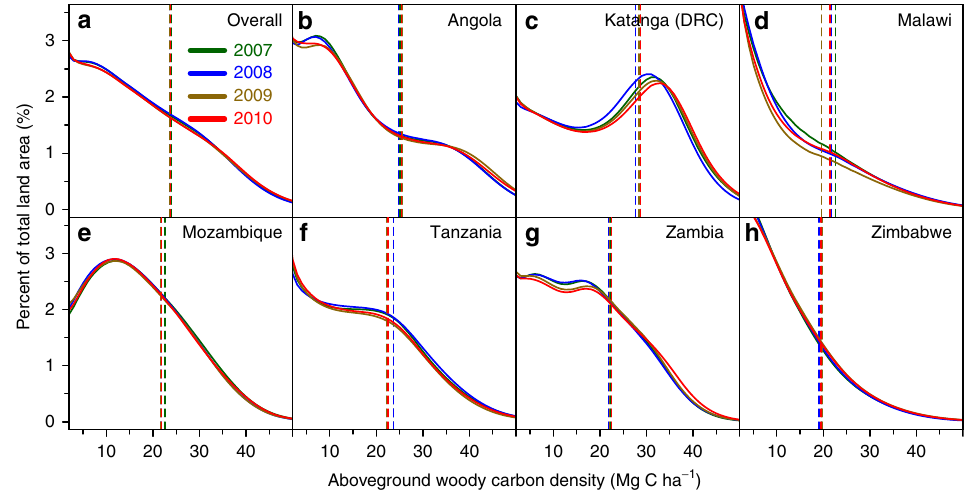
Fig. 2 Frequency distribution of aboveground woody carbon densitites. a – h The distribution of aboveground woody carbon densities, aggregated to 1 ha resolution, for our study region ( a ), and for each country ( b – h ), including the woodland dominated former Katanga Province of the DRC, from 2007 to 2010. The vertical lines indicate the yearly mean